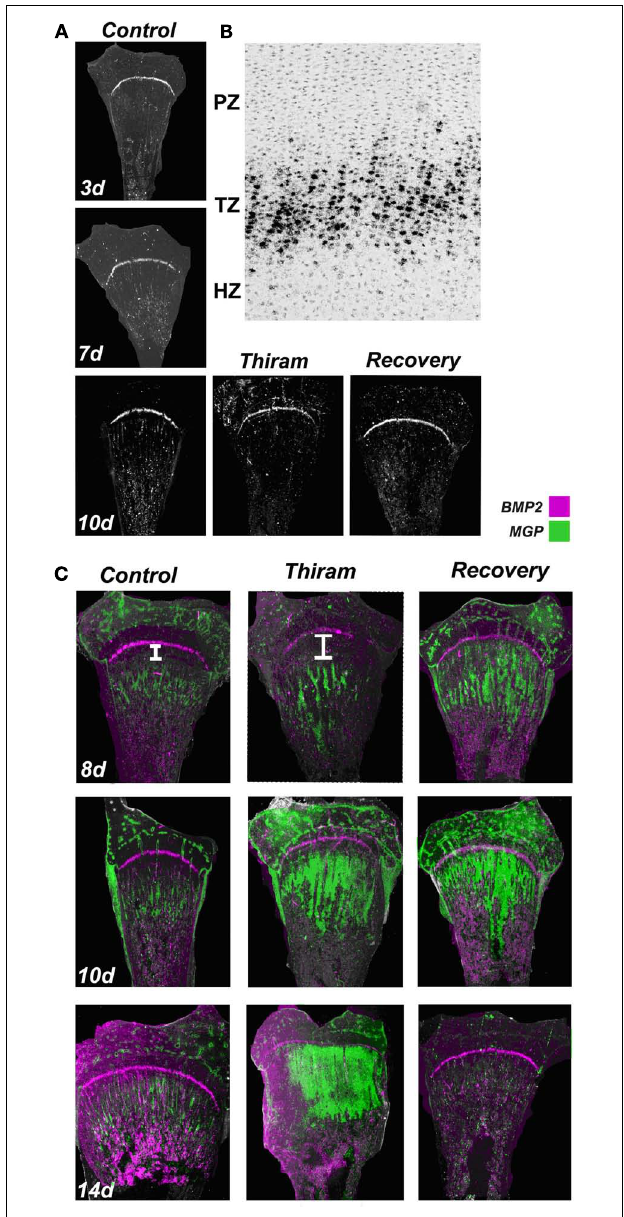
FIGURE 5 | Proximity between the expression zones of BMP2 and MGP in the growth plate. Whole growth plates were processed as described in Section “Materials and Methods” and subjected to in situ hybridization with 35 S-labeled riboprobes of the avian BMP2 or MGP. (A) BMP2 expression on days 3, 7, and 10 is restricted to the pre-hypertrophic (transition zone). BMP2 expression is not influenced by thiram or recovery ( × 7.5). (B) BMP2 expression in the transition zone (TZ). Bright field ( × 100). (C) Overlap of MGP (green) and BMP2 (purple) expression in control, thiram, and recovery ( × 7.5).White line in the upper panel demonstrates the gap formed between the expression zones of these two genes in the thiram group compared with the